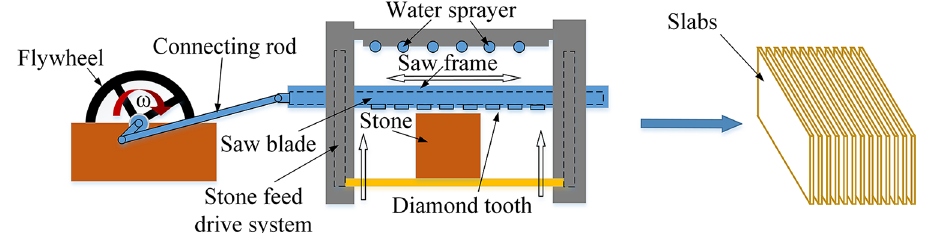
Fig. 1. Diagram of the frame saw machine for